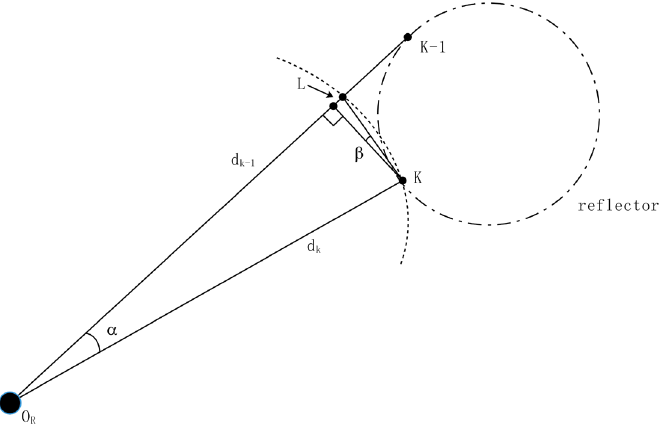
Figure 4. Calculation method of distance threshold D k between the adjacent data points.